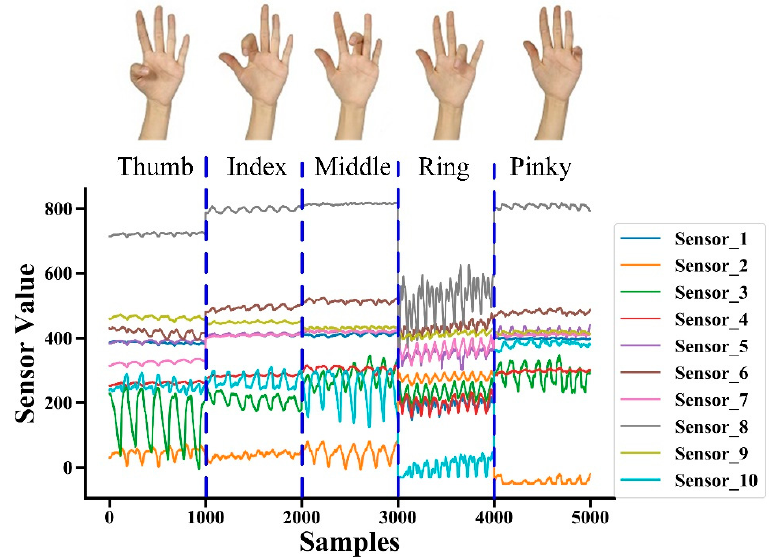
Figure 2. Raw signals from 10 modified barometric sensors for a typical trial (subject 1, trial 1) showing distinct patterns between each gesture.